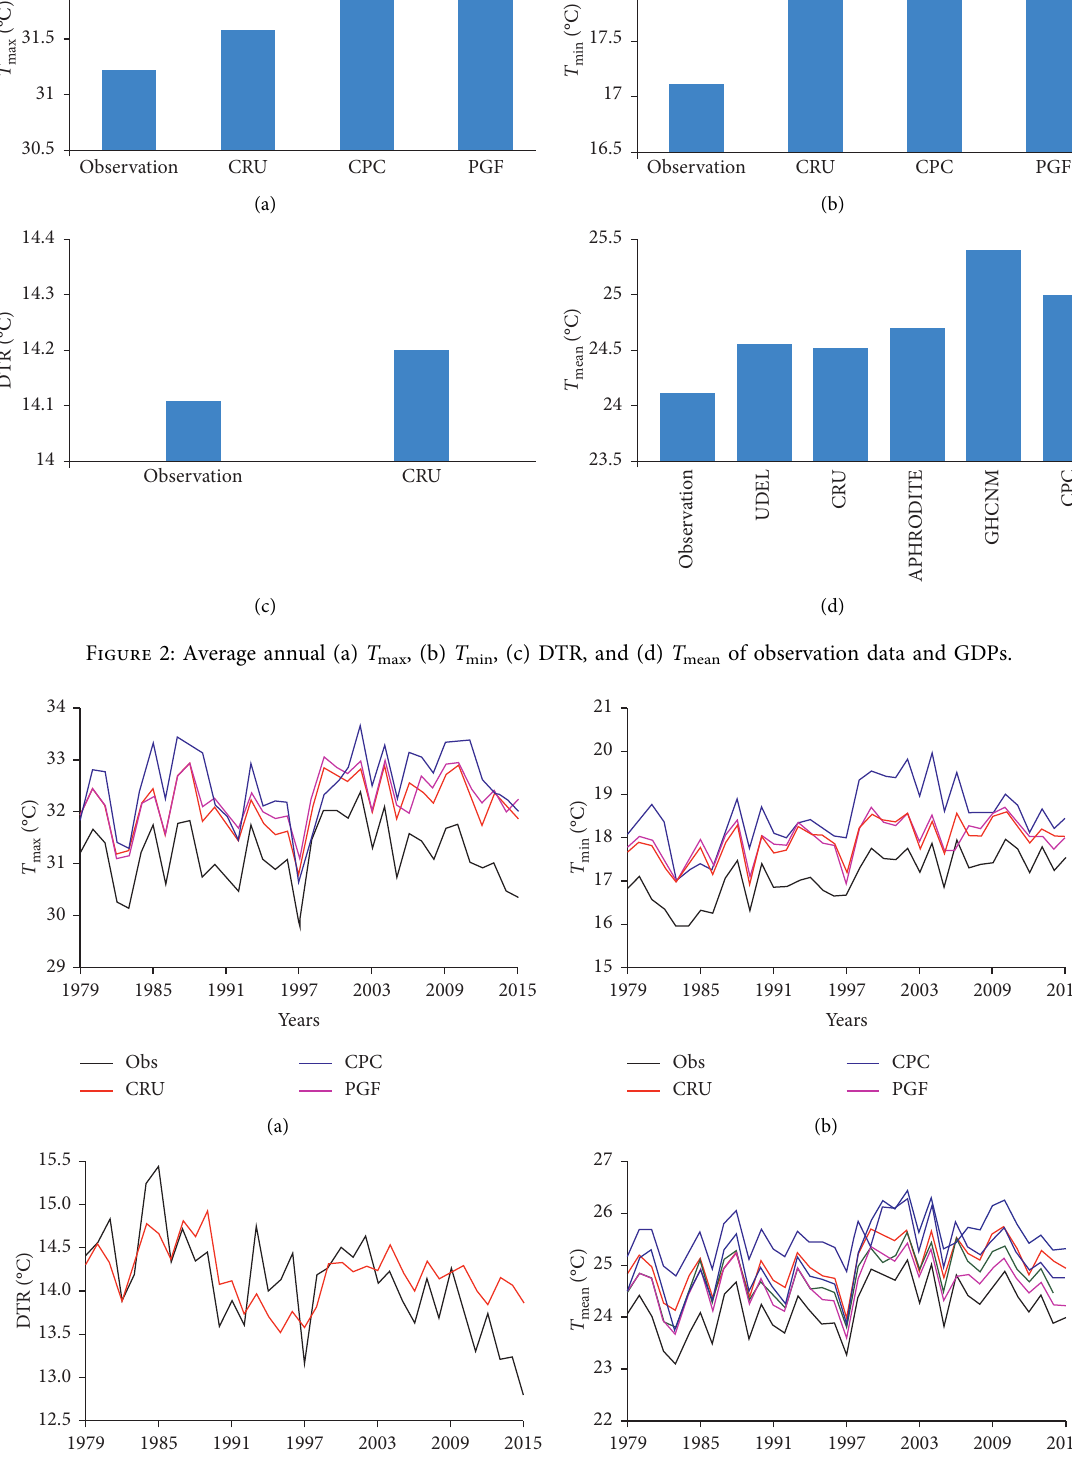
max , (b) T min , (c) DTR, and (d) T mean